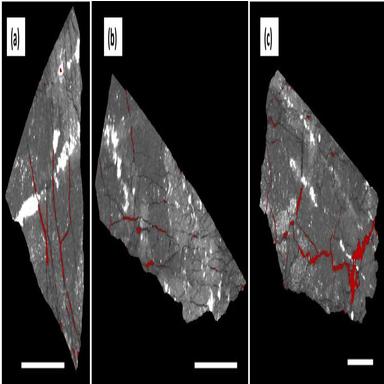
2D tomographic planes of a particle. Red color indicates the resolved fractures. A significant amount of fractures is below image resolution and thus not captured. Bright color indicates Cu minerals. Note the 1 mm scale bar in each image. (For interpretation of the references to color in this figure legend, the reader is referred to the web version of this article.)